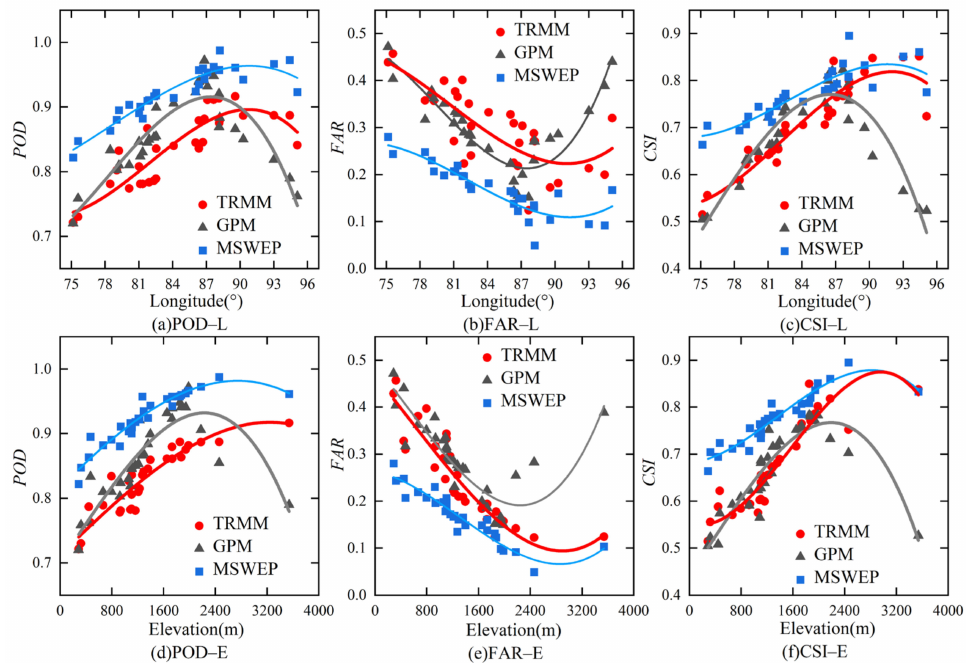
Figure 11. Scatter diagram and fitting lines of daily precipitation detection indicators and longitude ( a – c ) and elevation ( d – f ) of three